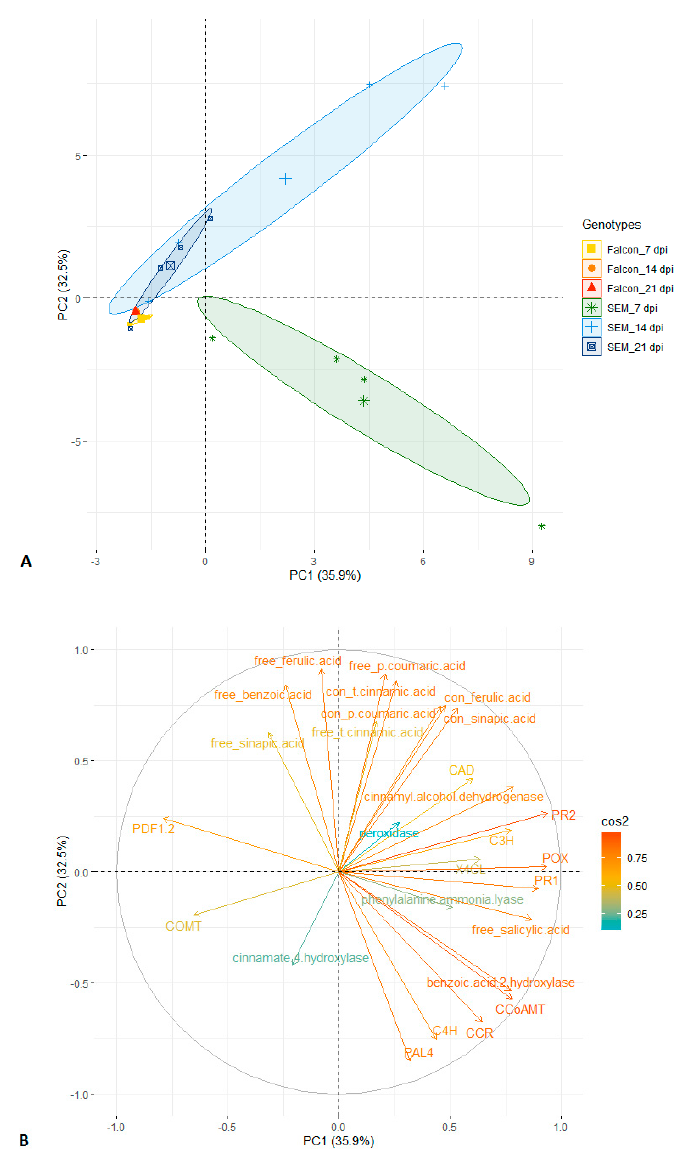
Figure 6. Principal component analysis of twenty-seven traits (metabolites, enzyme activities and gene expression) recorded in two B. napus genotypes with V. longisporum infection ( A ) and circles of cos 2 value of the variables ( B ). Labels of traits in capital letters are names of genes. Numbers of clusters were determined by elbow method. PC, principal component; con, conjugated form.